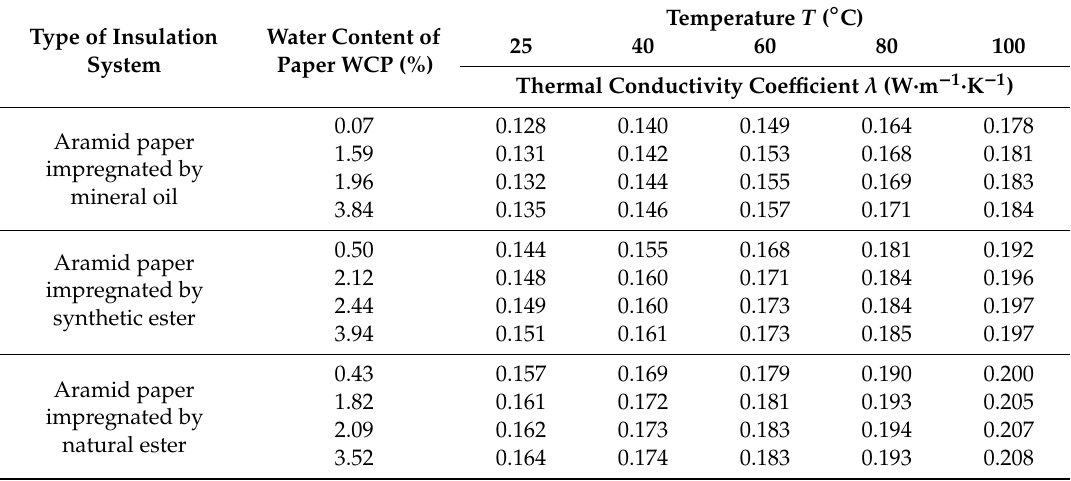
Table 4. Thermal conductivity coe ffi cient λ of aramid paper impregnated by various dielectric liquids depending on the water content of paper WCP, at di ff erent temperatures T